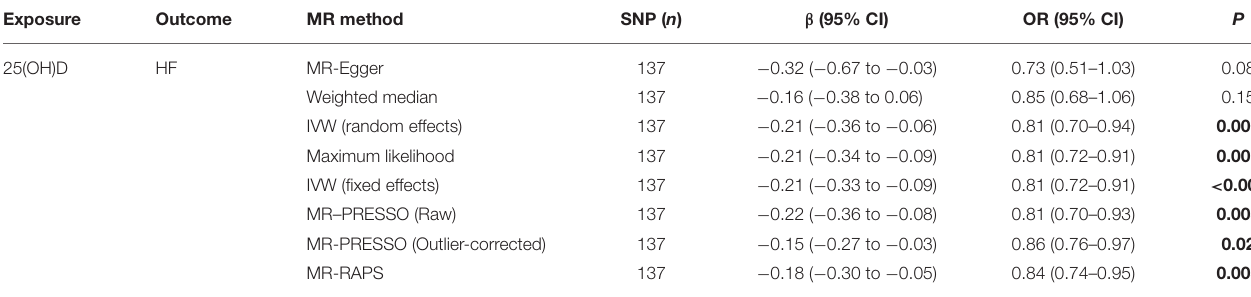
TABLE 2 | Mendelian randomization of circulating 25-hydroxyvitamin D levels and the risk of Heart failure. Exposure Outcome